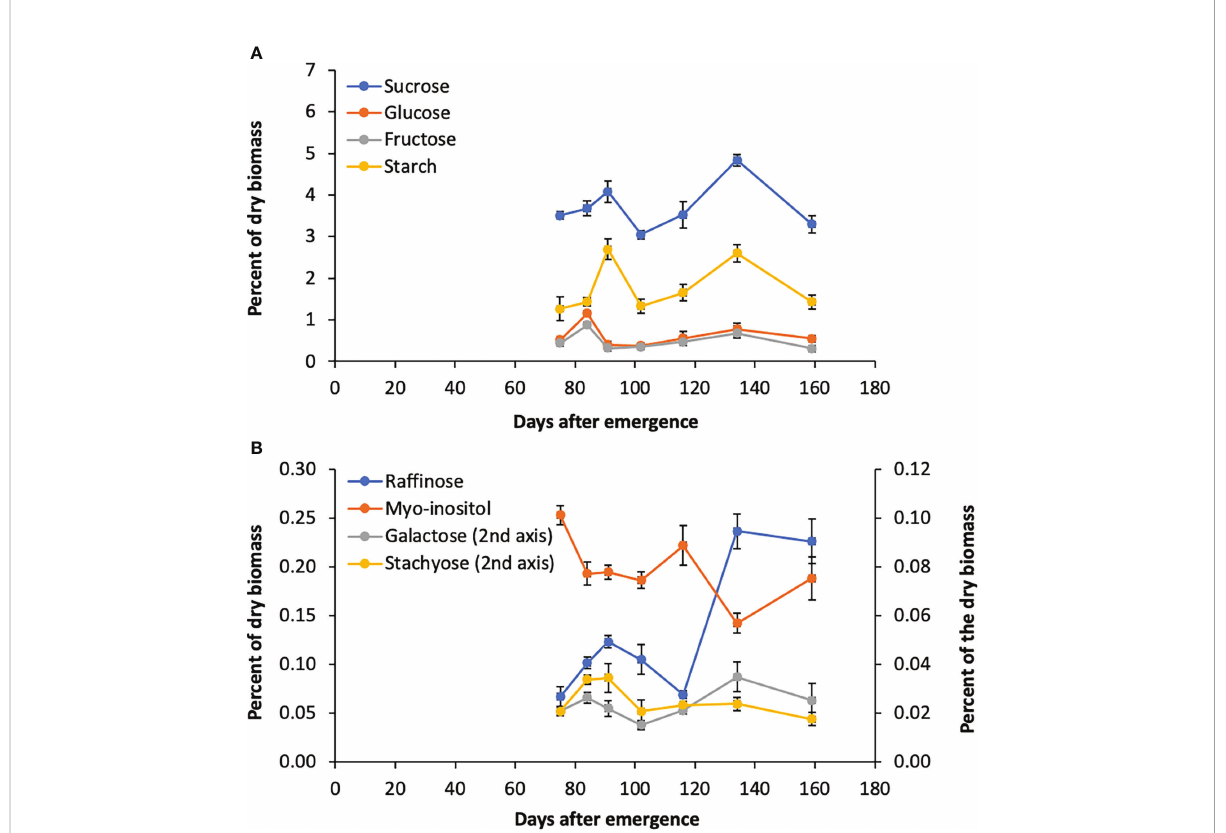
FIGURE 5 Sugar levels in Della fl ag leaves from fl oral initiation to post-grain maturity. (A) Levels of sucrose, glucose, fructose, and starch during development. (B) Raf fi nose, myo-inositol, galactose, and stachyose levels during development. Each data point is the mean of three biological replicates. Error bars represent S.E.M.